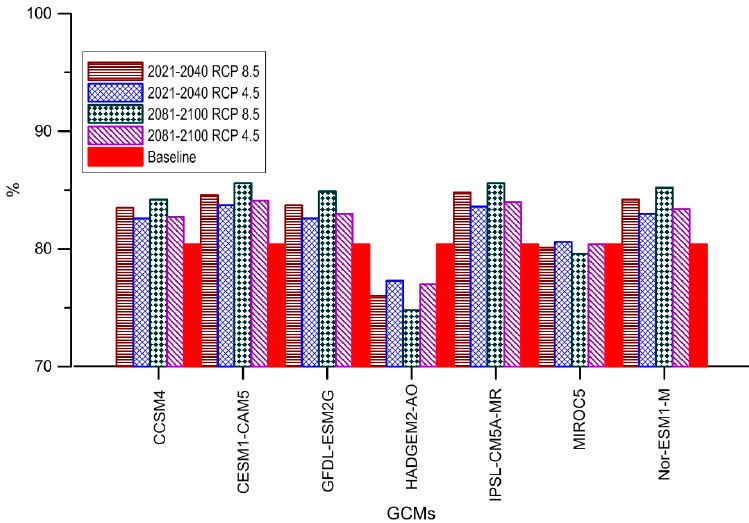
Figure 8. Seasonal Variability Index of flow in percentages with different GCMs and RCPs over two periods compared to that of the baseline.